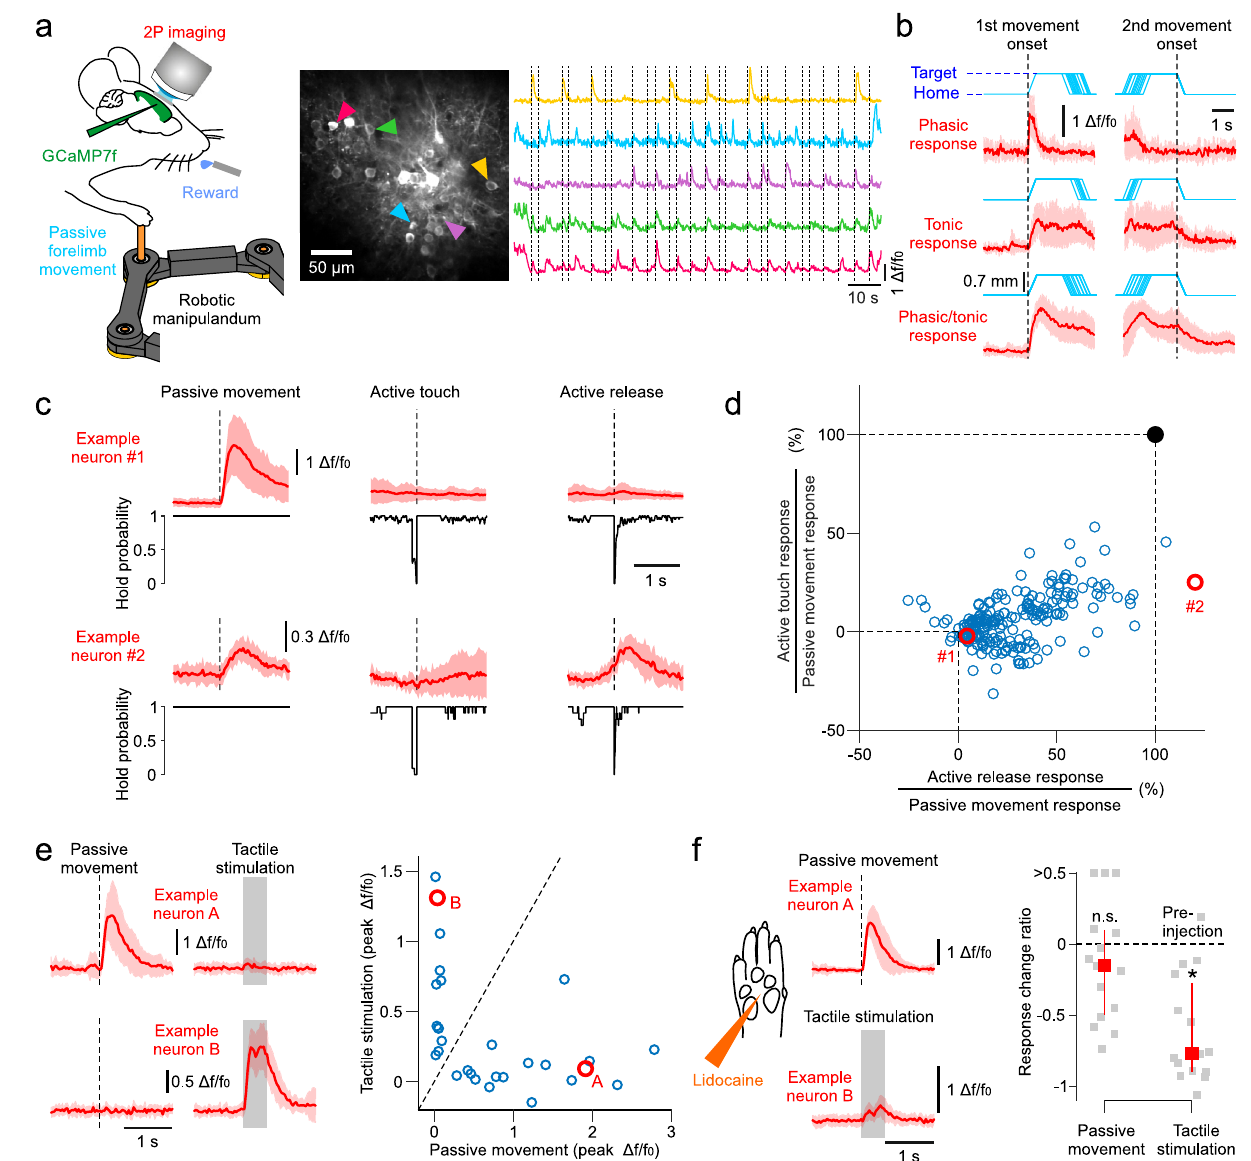
Fig. 5 | Ca 2+ imaging of proprioceptive neuronal responses in the mouse fore- limb S1. a Left, experiment schematic of the passive forelimb displacement task with simultaneous two-photon imaging of cortical neurons transfected with GCaMP. Right, cropped two-photon image of the forelimb somatosensory cortex and Ca 2+ dependent activity traces of fi ve neurons responding at the onset of passive forelimb movements (dotted lines, eight different directions tested). b Three types of observed proprioceptive responses. Δ f/f 0 mean (±s.d.) traces of three example neurons (red) aligned to fi rst movement (home-to-target) and sec- ond movement (target-to-home) onset (cyan: individual movement trajectories). c Mean (±s.d.) responses (red) of two example neurons to passive forelimb movement, active touch, and active release of the manipulandum. Black traces: instantaneous probability to hold the manipulandum across trials. d Peak